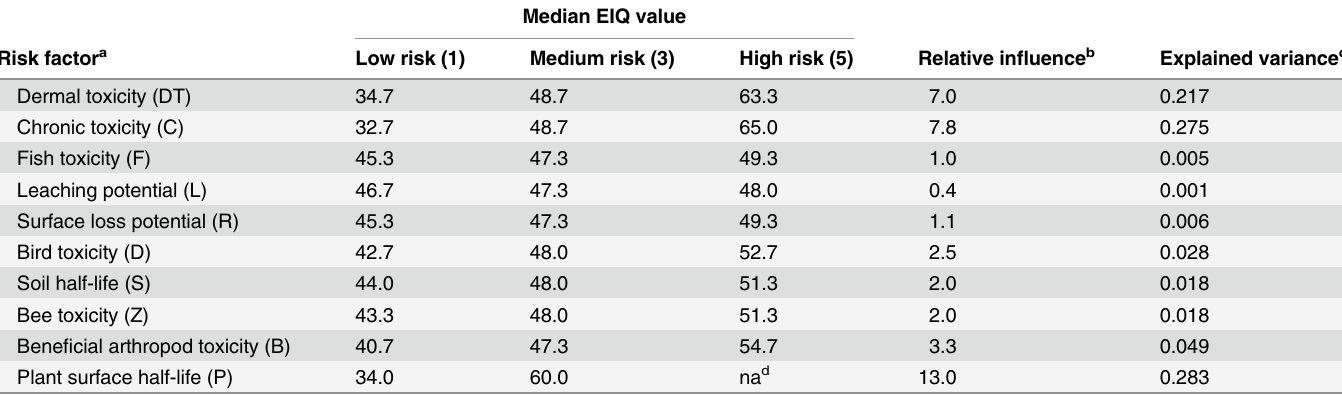
Table 1. The influence of risk factors on the calculated environmental impact quotient (EIQ) as determined by simulation analysis (N = 100,000). Median EIQ value